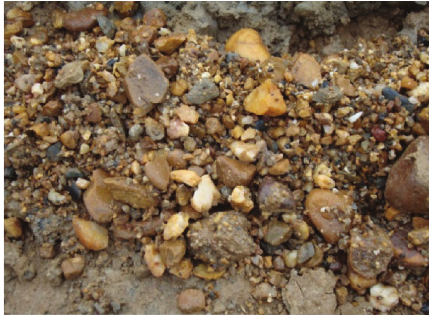
Figure 4: Core sample of sandy and gravel stratum.